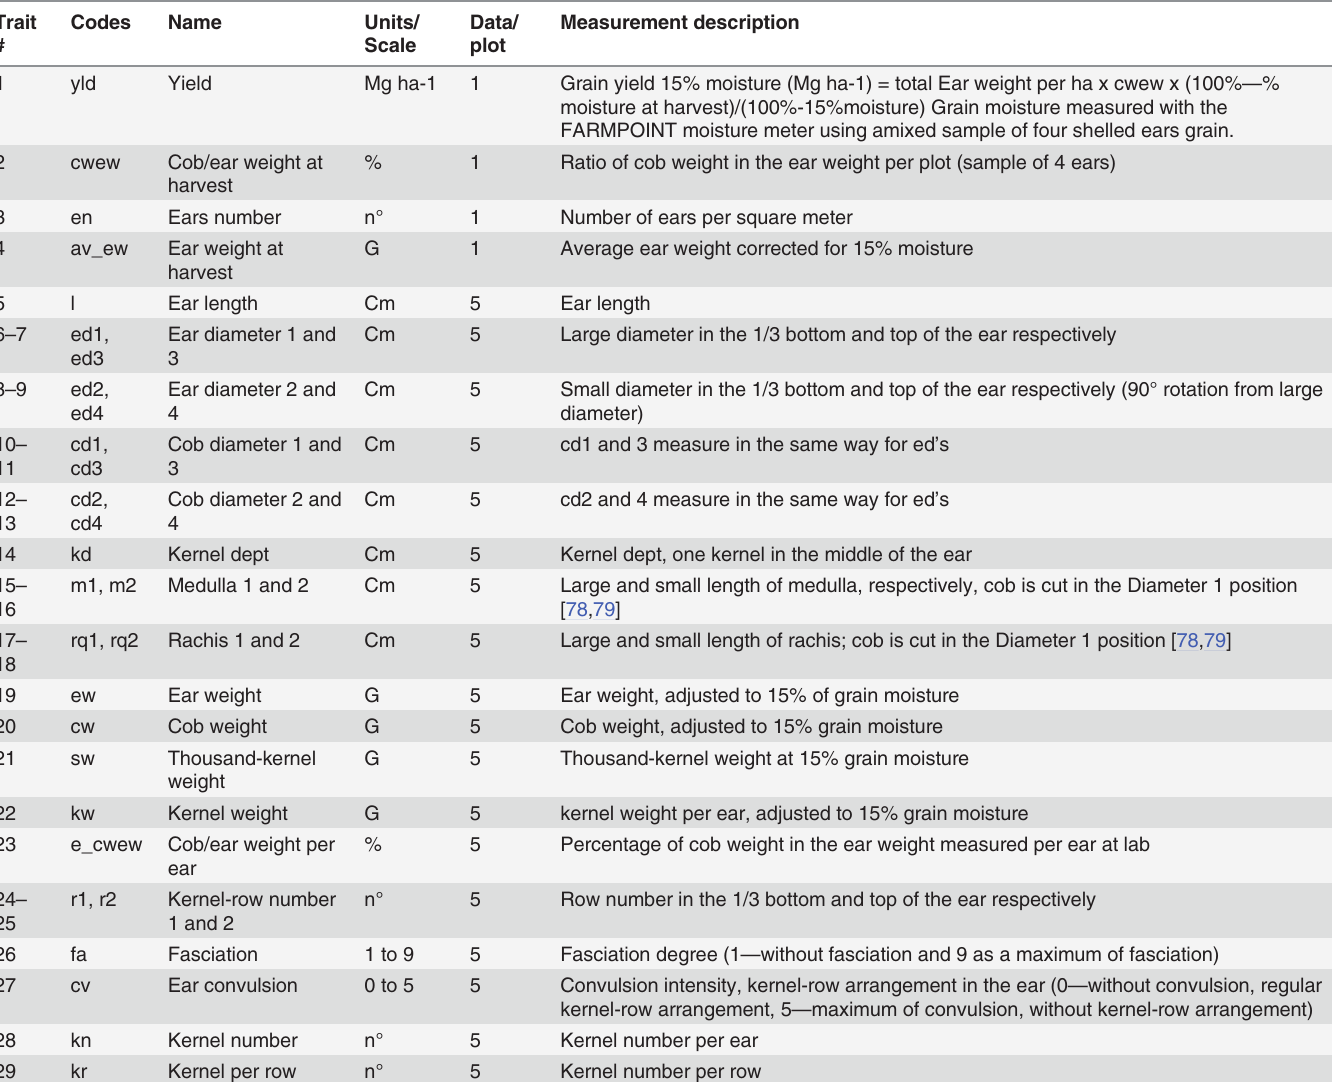
Table 1. Traits measured, codes and respective description of